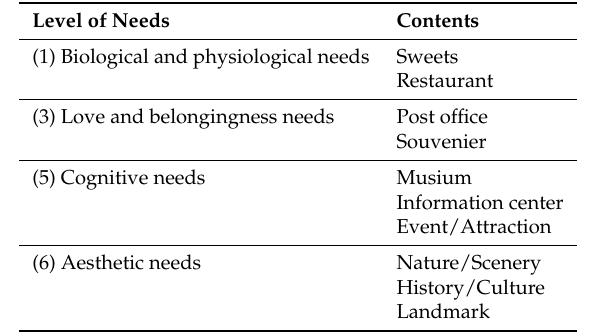
Table 3. Classification of information based on the idea of Maslow’s hierarchy of needs.